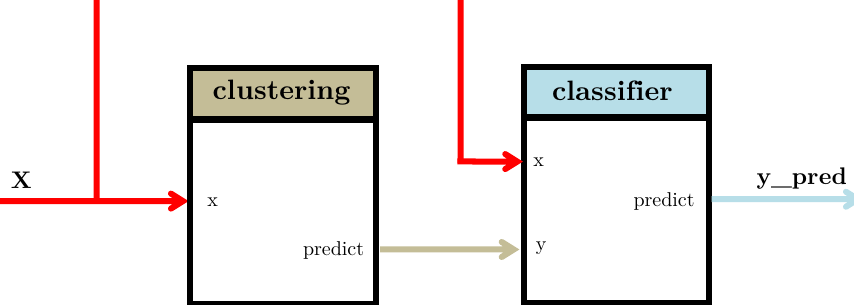
Figure 3. A pipegraph sporting two sequential model blocks.